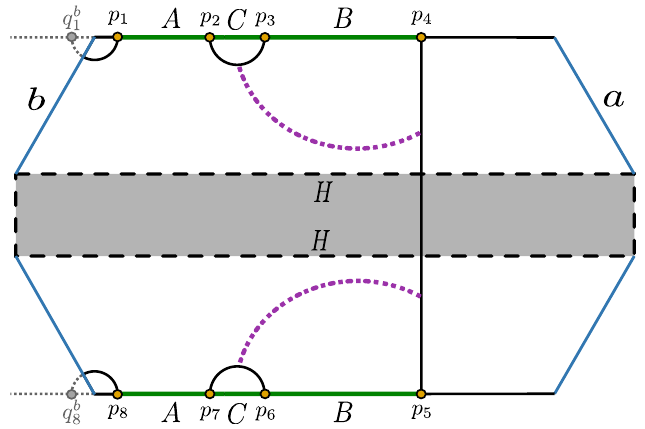
Figure 29 . The endpoints of the intervals A and B and the image points in the two BCFT 2 copies are identified similarly as in figure 20 with p 4 = p 5 = r 4